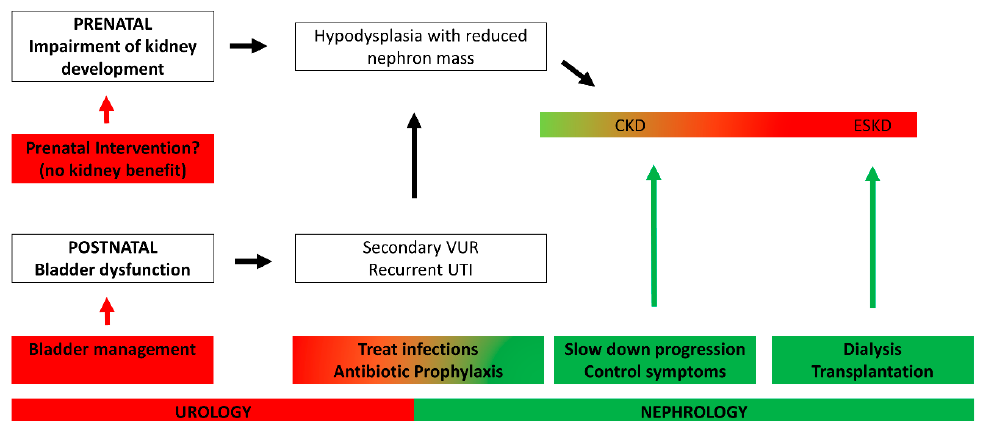
Figure 3. Interventions to prevent and treat chronic kidney disease in posterior urethral valves. Prenatal intervention with vesicoamniotic shunting or fetal cystoscopy yields no renal benefit. Bladder dysfunctions should be treated because they increase the risks of developing chronic kidney disease (CKD). Urinary tract infections (UTI) should be treated, and possibly a prophylaxis should be administered. All boys should be regularly seen by a pediatric nephrologist, in order to assess possible CKD. CKD progression should be slowed down, and CKD symptoms should be treated. In end-stage kidney disease (ESKD), dialysis or preferably transplantation is necessary.